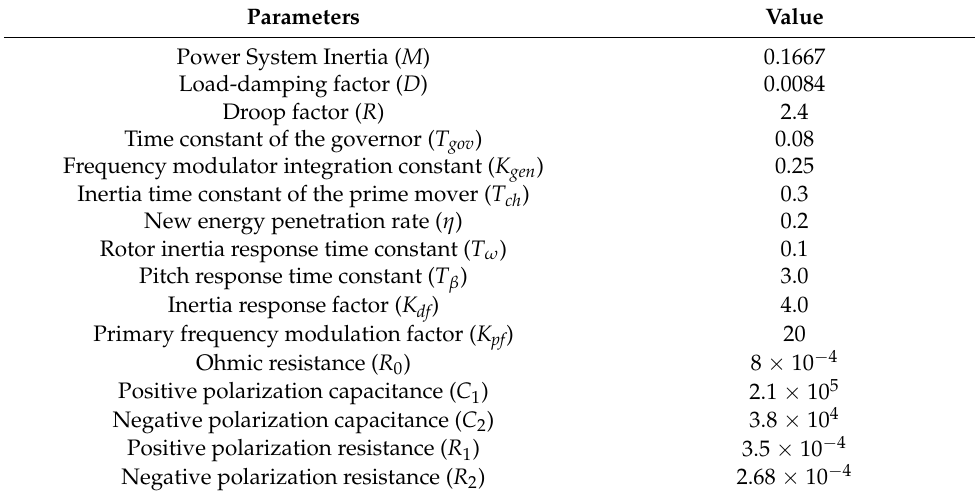
Table 5. The parameters of the